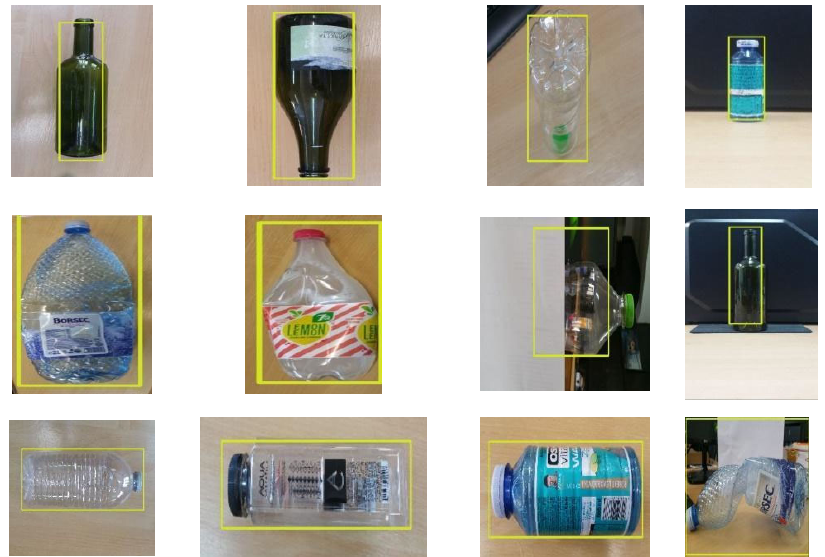
Figure 8. Custom dataset predictions for one object in image.